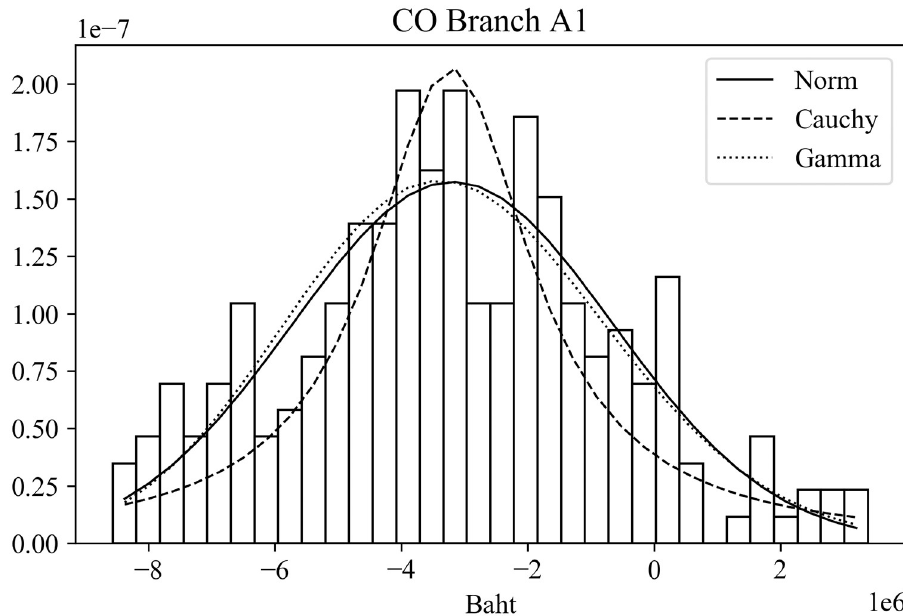
Fig 8. Examples of error distribution fitting results of CO.